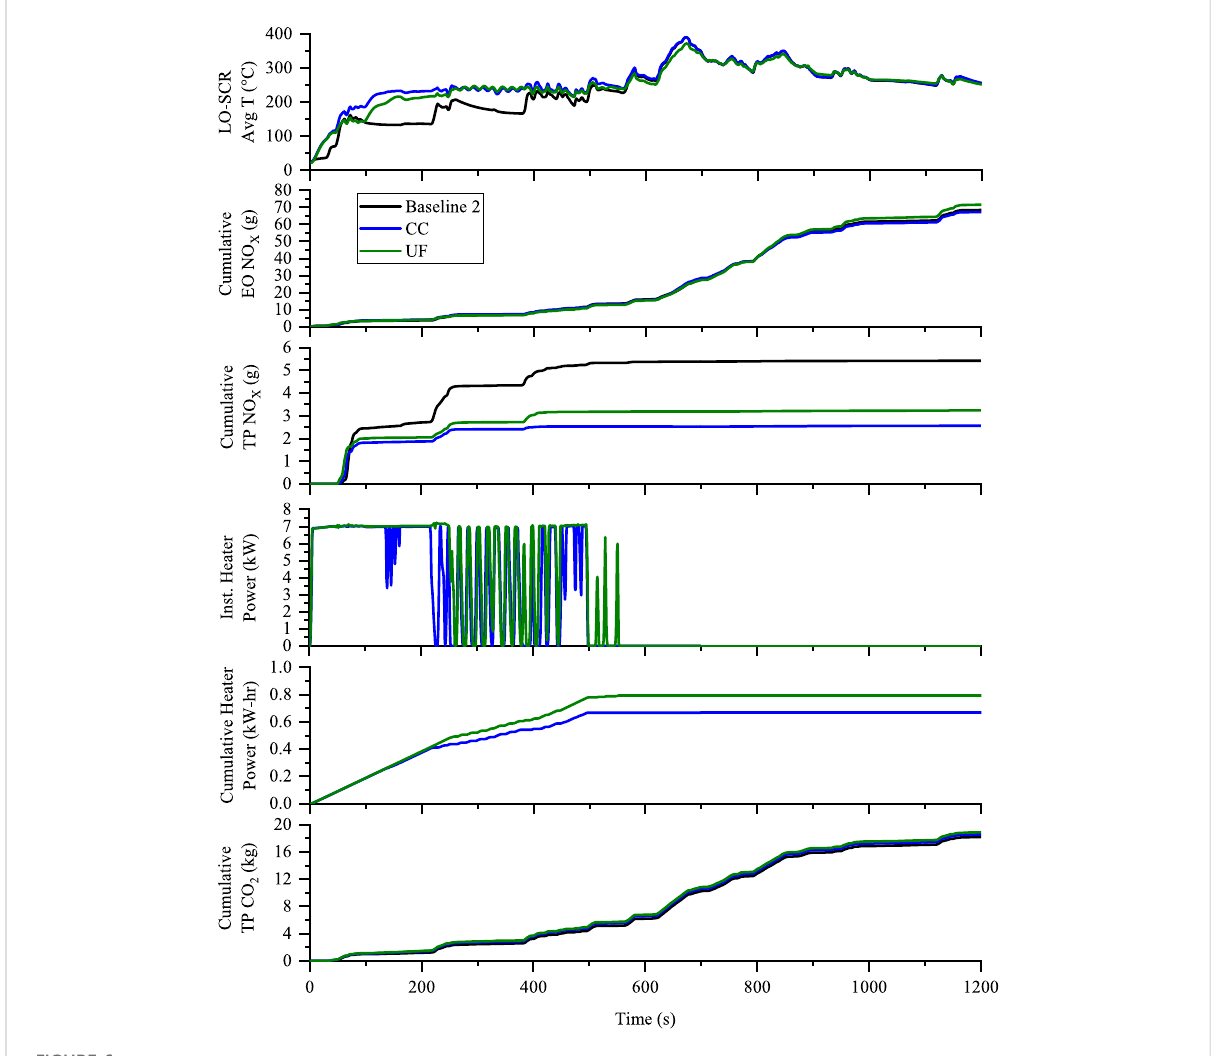
FIGURE 6 Comparison of the CC LO-SCR and UF LO-SCR to Baseline 2 on a Cold FTP cycle for the LO-SCR average temperature, emissions, and heater electrical power